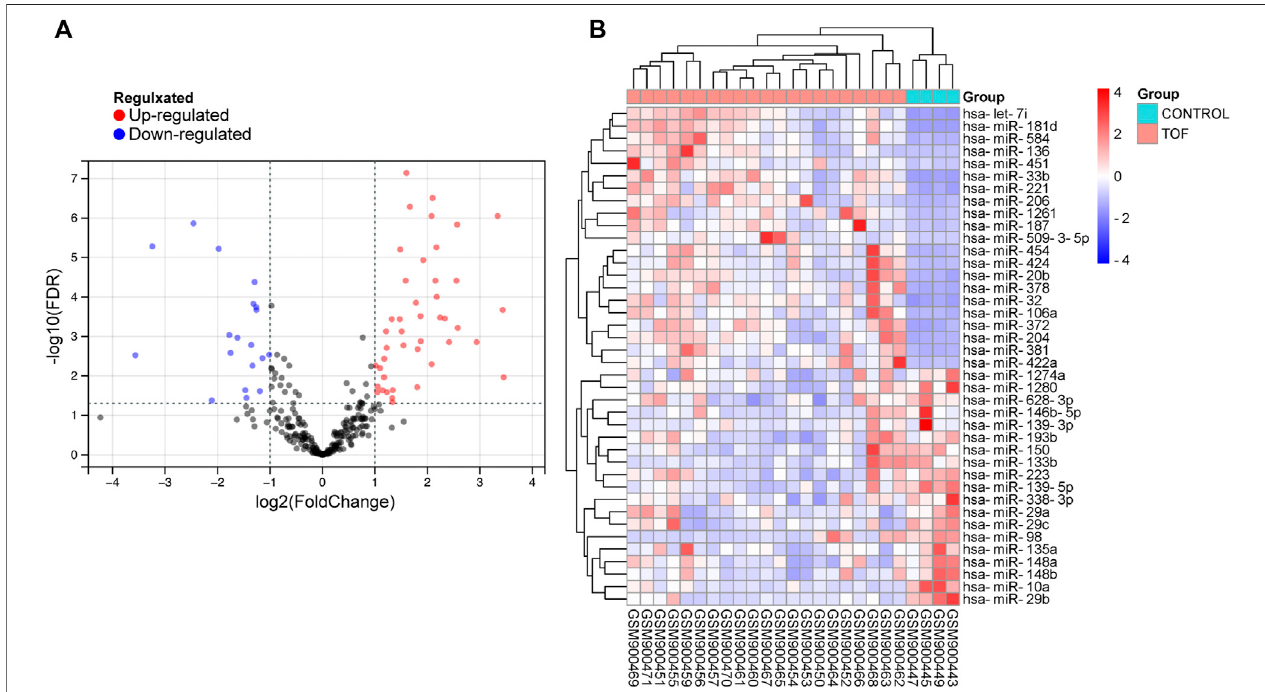
FIGURE 4 | Acquire differentially expressed circRNAs (DEcircRNA) of TOF. (A) Volcano plots for DEcircRNAs, the red and green points represent up and down expressed DEcircRNAs respectively. (B) A heatmap for 40 DEcircRNAs we selected, the change in color represents the difference in expression.